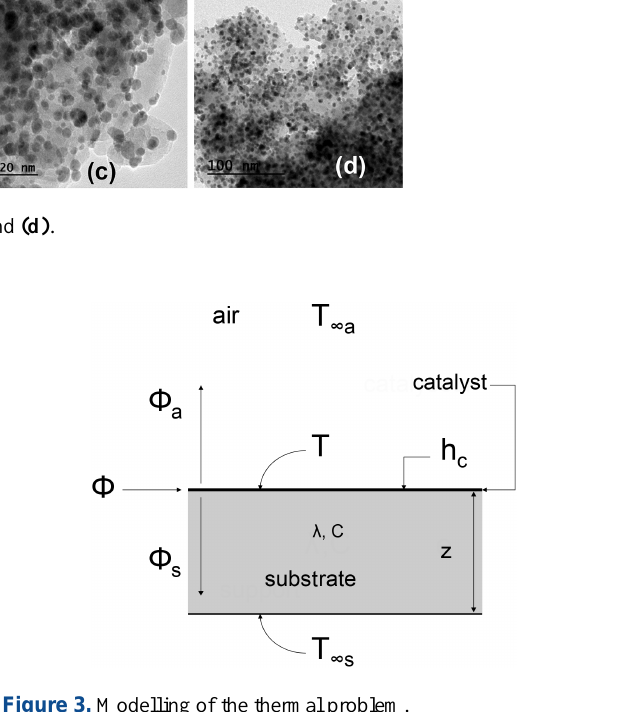
Figure 2. Dependence of H 2 conversion over PdPt / Al 2 O 3 versus temperature in a mixture of 0.5%H 2 + 10%O 2 in He for 5.5mg of synthesised catalysts A, B and C.